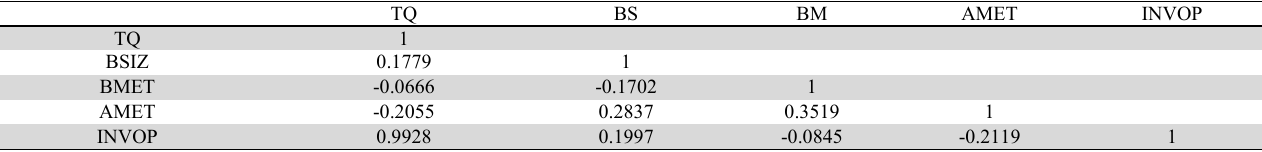
Correlation Matrix